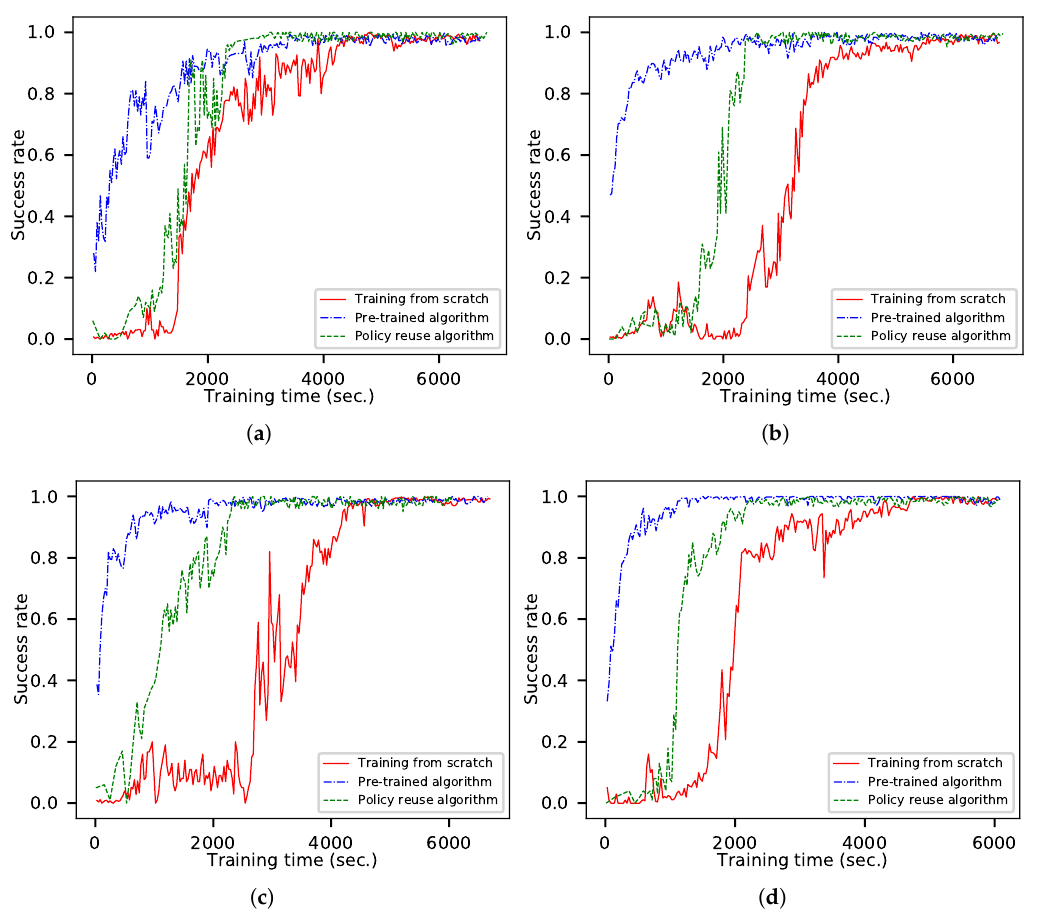
Figure 9. Policy reuse for agent training in curved-motion destination scenario: destination turning